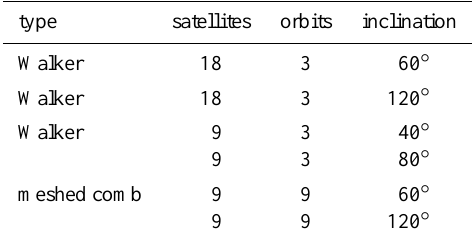
Table 1. Four constellations with 18satellites at 900km altitude but with different inclination angles and number of orbits. The constel- lation in row 3 consists is a combination of two 9/3 Walker constel- lations with different inclination angles.